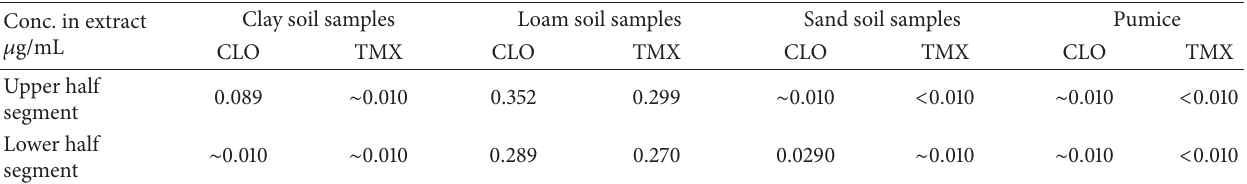
Table 3: Residues of CLO and TMX in soil columns. Residues of neonicotinoids absorbed on the soil and pumice columns. Residual levels were separately determined in the upper and lower half segments of the columns after preparation of samples by QuEChERS method. Conc. in extract 𝜇